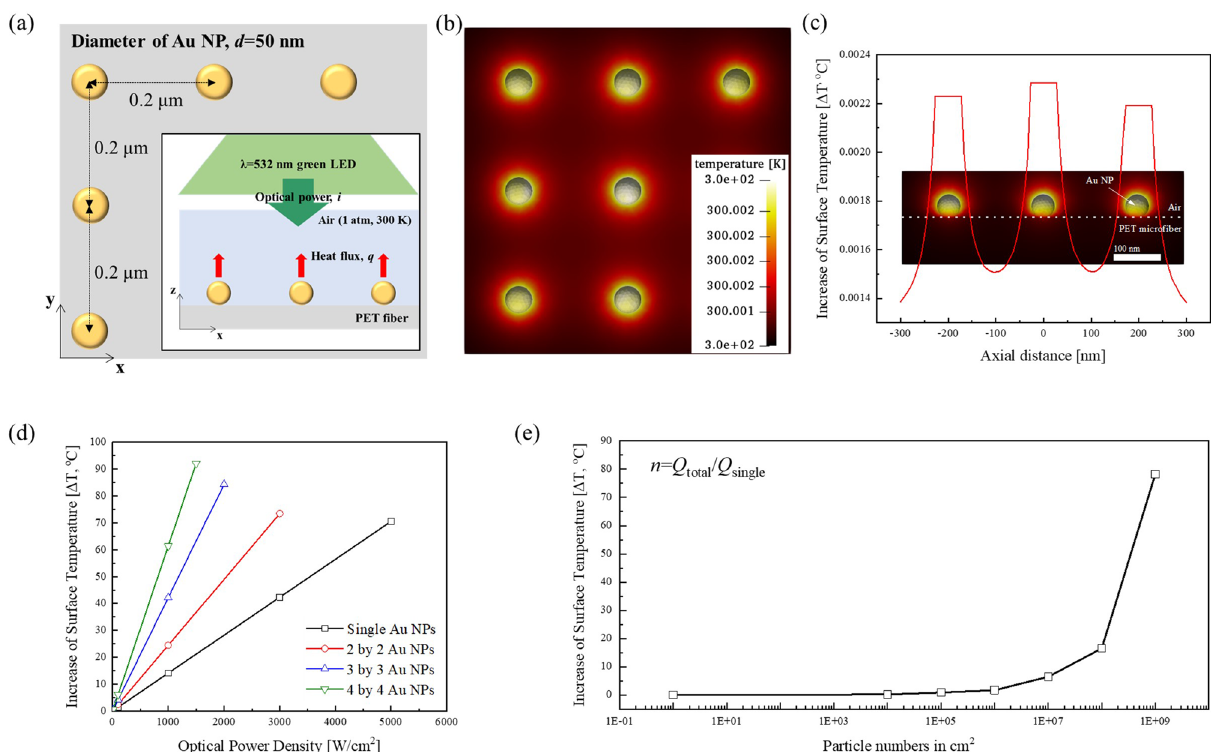
Figure 1. Simulation of the photothermal effect generated by Au NPs on a PET microfiber supporting layer. ( a ) Configuration of Au NPs arrays on the PET microfiber and LED light irradiation. The inset shows a side view of the Au NPs array. ( b , c ) Top view and side view of temperature distribution by the photothermal effect of 3 × 3 Au NPs array under an optical power density of 100 mW/cm 2 . ( d ) Variation of surface temperature with respect to the size of Au NPs arrays under different optical power densities. ( e ) Simplified estimation for surface temperature versus particle numbers per cm 2 under an optical power density of 100 mW/cm 2